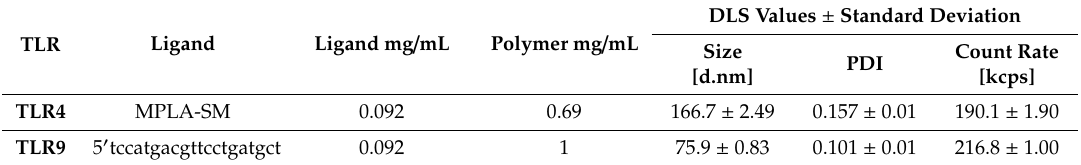
Table 1. Nanoparticle formulations and particle population